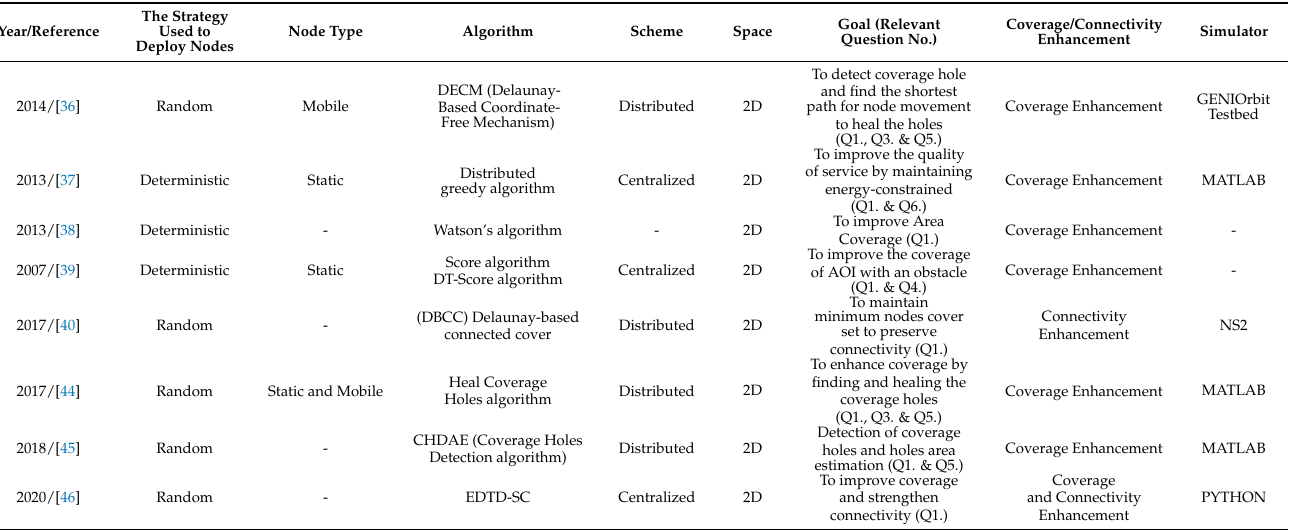
Table 3. Overview of Different Delaunay Triangulation-Based Techniques to Improve Coverage and Connectivity in WSNs.